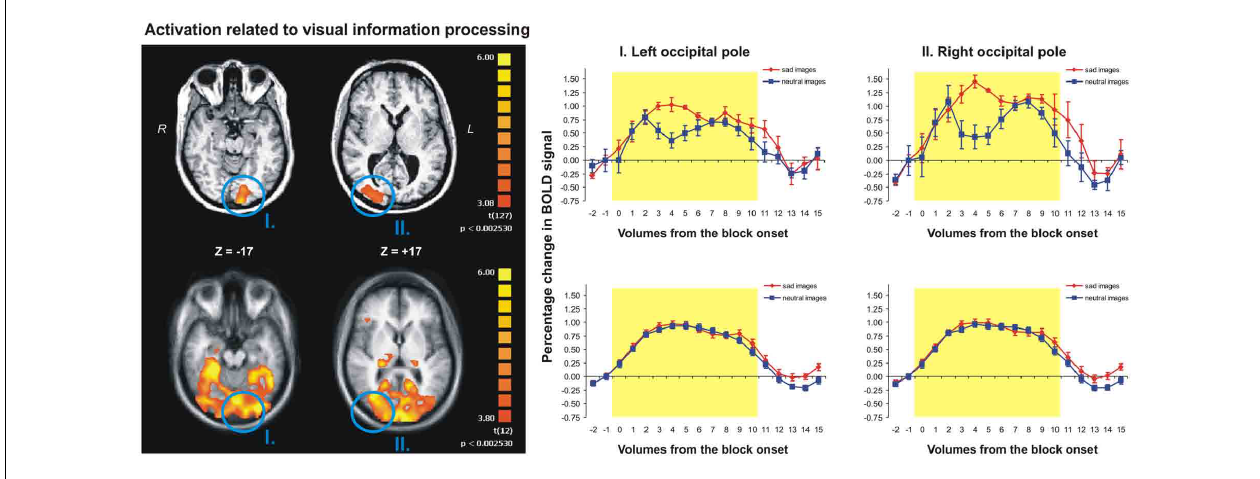
stimulation for emotionally charged (red lines) and neutral (blue lines) stimuli.The upper images and the upper graphs pertain to the schizophrenia patient with CC agenesis, whereas the lower images and graphs reflect the group average (13 schizophrenia patients with no apparent CC agenesis).